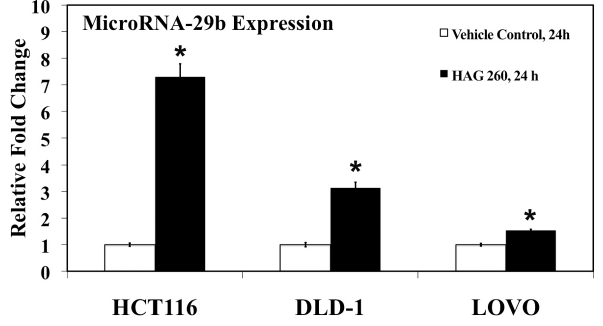
Figure 1. miRNA-29b expression increases in colon cancer cells after exposure to Hexane fraction of American Ginseng (HAG). HCT 116, DLD-1, and LOVO cells were exposed to 260 m g/mL HAG for 24 h (n=3 per time point). Relative endogenous miR-29b expression levels were detected by qRT-PCR using Taqman primers and probes to detect mature miR-29b and the small nuclear RNA RNU6B (U6), an internal control. Relative miR-29b expression levels were normalized to the average value of the non-treated samples (0 h). *, indicates significant difference (pvalue , 0.005) from the 0 h control.